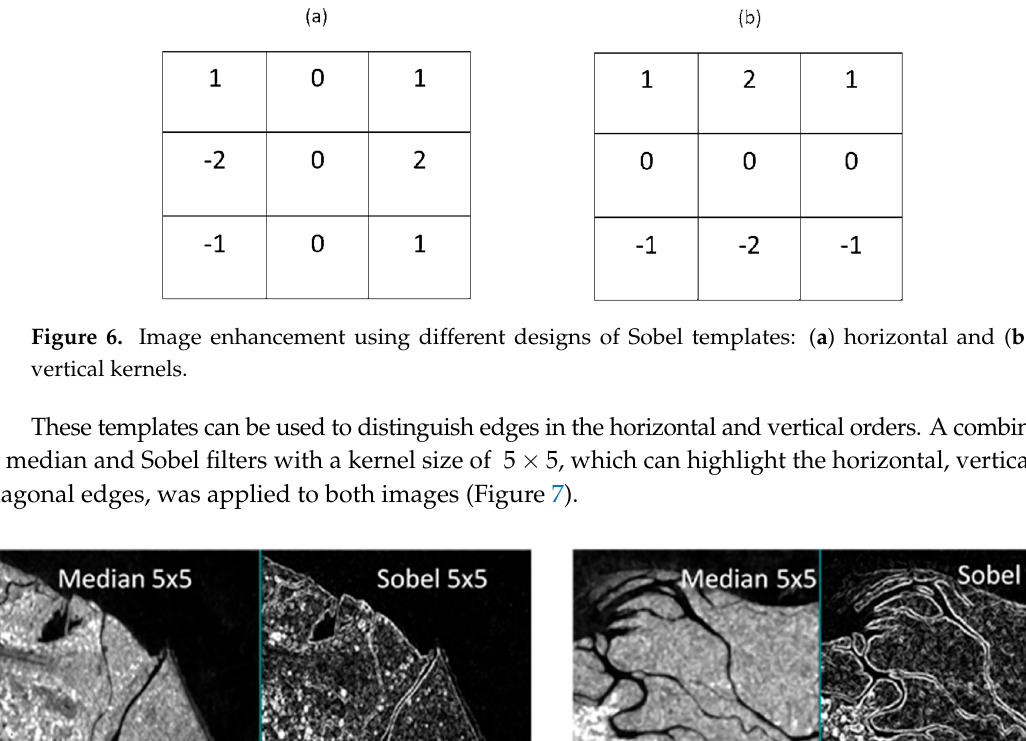
Figure 7. Median and Sobel filters with a kernel size of 5 × 5 .